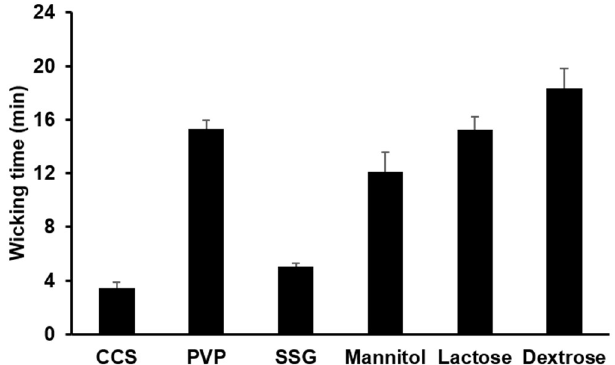
Figure 3. Water wicking time of different hydrophilic materials. The water wicking time was determined by measuring the time taken for the hydrophilic materials filled in capillary tubes at a height of 5 cm to fully absorb an aqueous solution of methylene blue. CCS, PVP, and SSG are abbreviations for croscarmellose sodium, polyvinylpyrrolidone, and sodium starch glycolate, respectively. The values are mean ± SD ( n = 3).